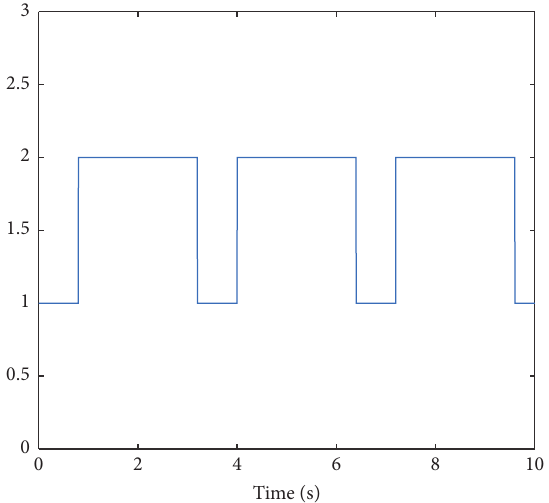
Figure 2: Switching signal of system (1) with MDADT.